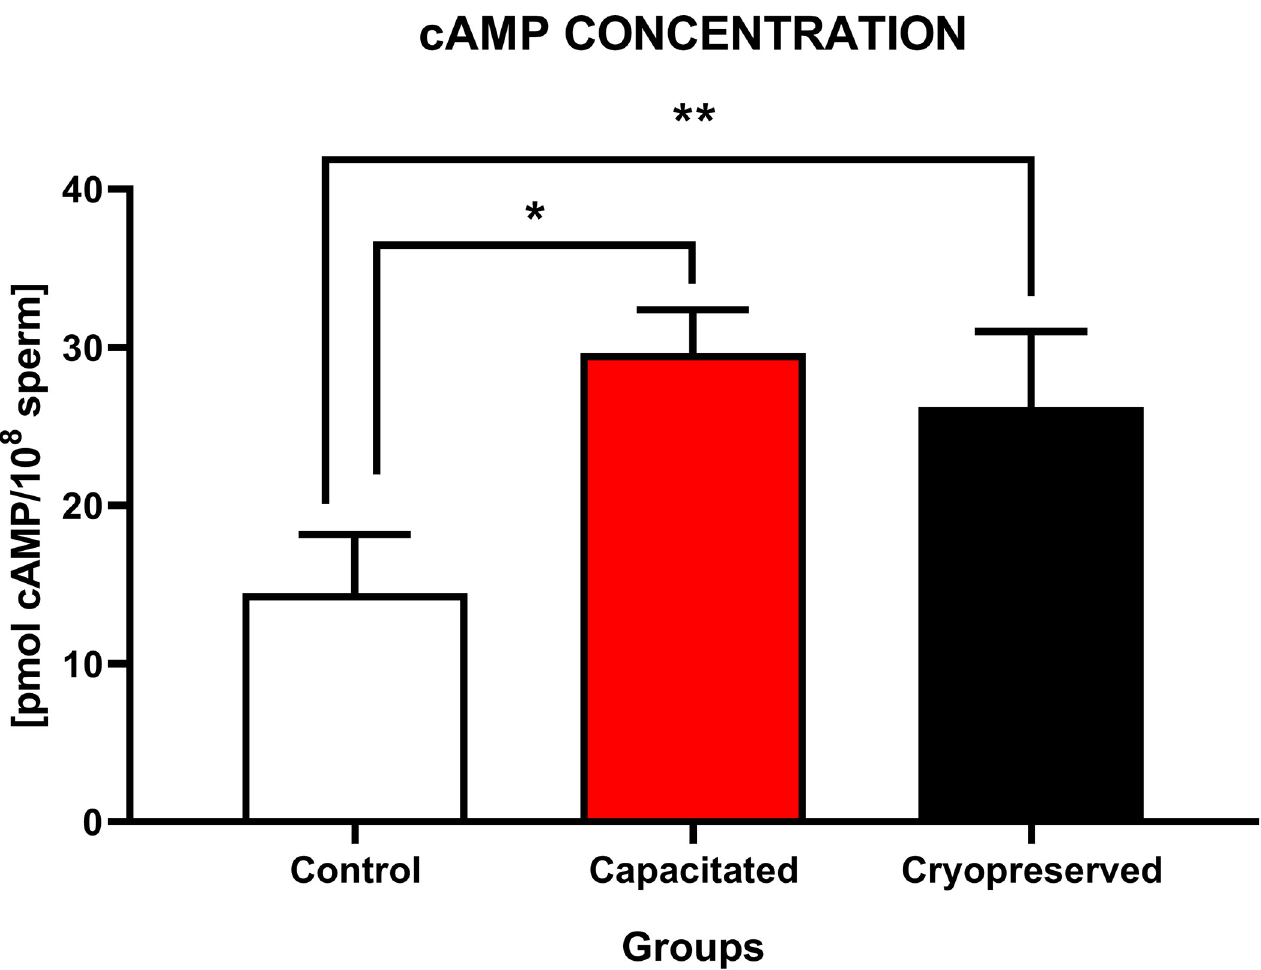
Fig 4. The concentration of cyclic adenosine monophosphate (cAMP) in non-capacitated, in vitro capacitated and cryopreserved bovine spermatozoa. The graph represented the concentration of cAMP (pmol cAMP/10 8 ) between the groups ( ± SD). The level of significance was set at � P < 0.05; �� P < 0.01; ��� P < 0.001; ���� P <